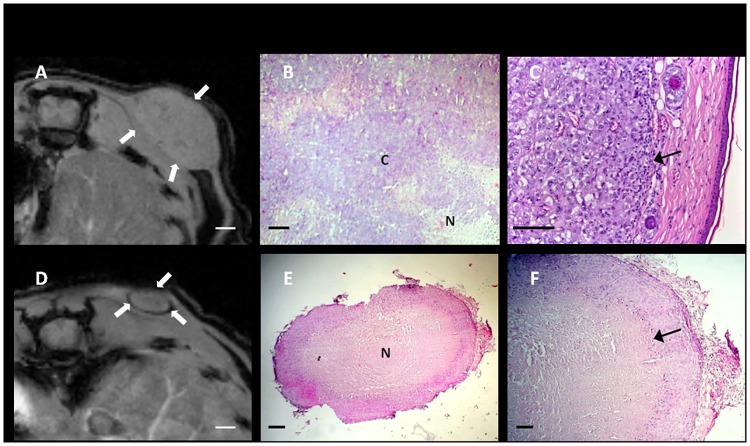
Representative MR images and H&E stained tumor samples.A growing tumor (A-C) and a non-growing tumor specimen (D-F). White arrows are pointing to the tumor mass, some areas show inflammatory infiltration (black arrows) N = Necrotic tissue, C = Carcinoma. Bar in (A) and (D), 1 mm. Bar in (B), (C) and (F), 100 μm. Bar in (E), 250 μm.